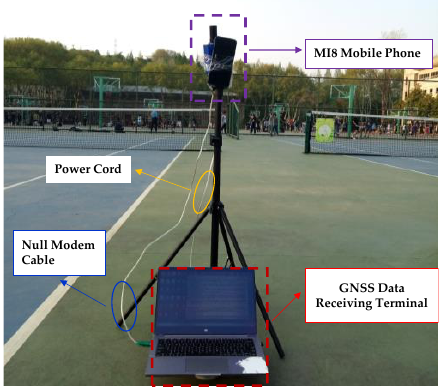
Figure 7. GNSS positioning experiment scenario.